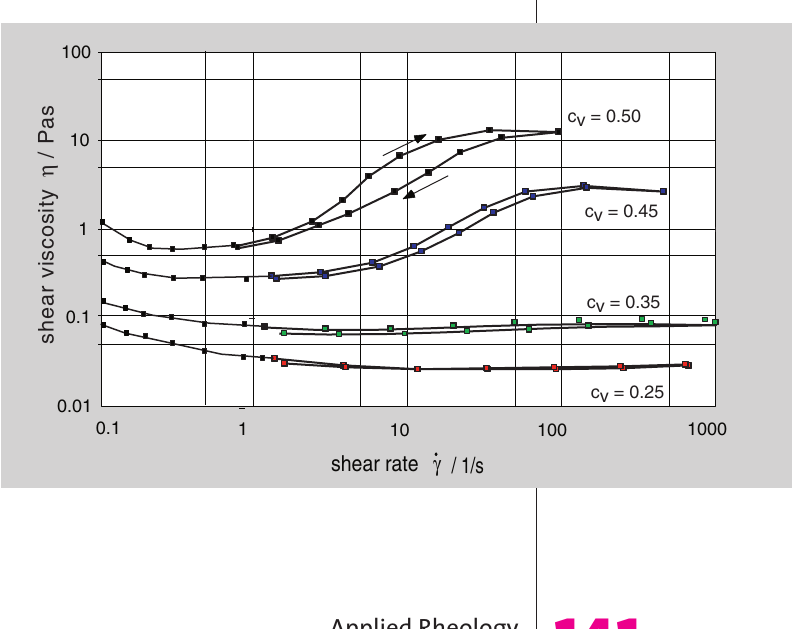
Figure 10: Measured viscosity functions for starch particle/glucose syrup suspensions with dilatant shear flow behavior (25°C,